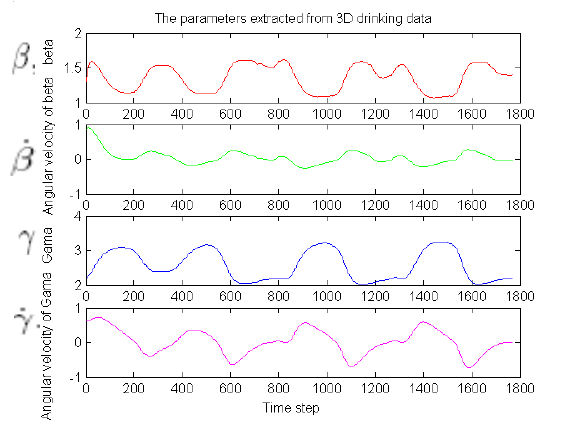
Figure 10. The features extracted from the 3 axis accelerometer of drinking activity.